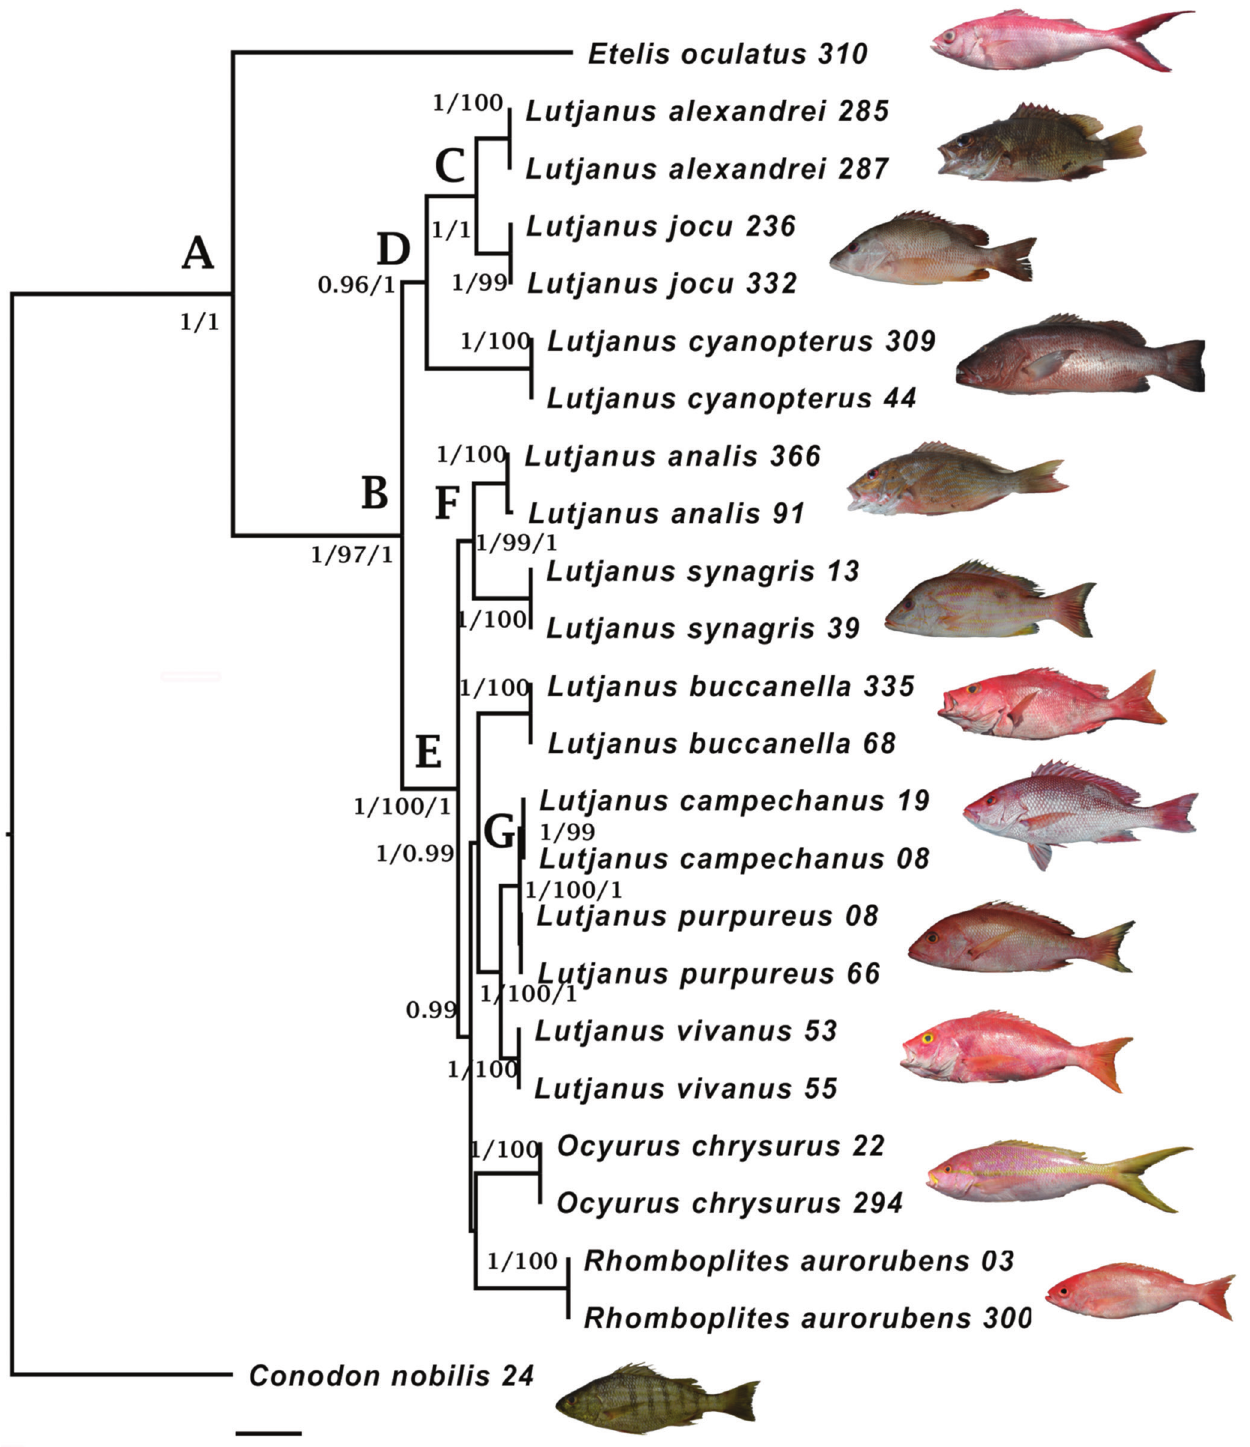
Fig. 1. Phylogenetic relationships in Lutjaninae species from the Western Atlantic estimated by Bayesian (BI), maximum likelihood (ML) and a Species Tre analyses inferences based on a data matrix (4.4 kb) comprising mitochondrial (16S rRNA, COI, cyt b, and ND-4) and nuclear (Rhodopsin, TMO4C4 and RAG-1) markers. The BI topology is presented with the posterior probability (BI and Species Tree) and bootstrap (ML) values. The letters in the nodes refer to the clades discussed in the